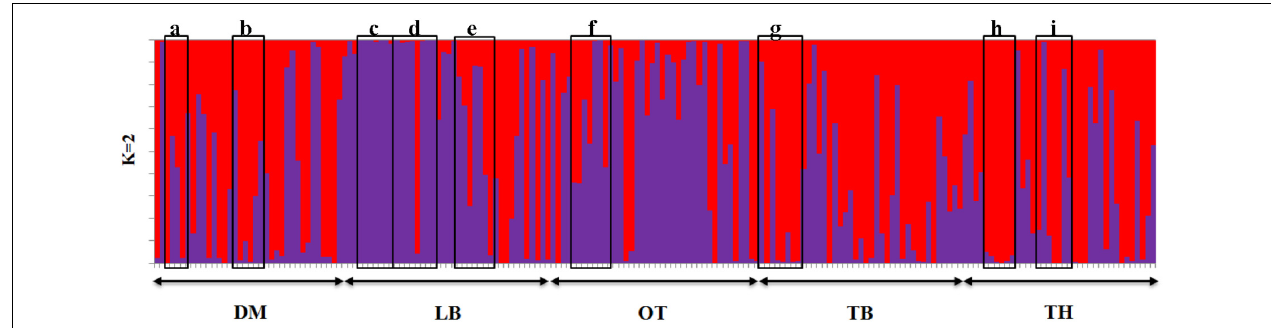
FIGURE 10 | Households having more than five birds in the sampled population (from a–i). Phenotypes in (c) nacked neck and village chicken; (d) village chicken, frizzle feathered, commercial layer; (h) village chicken, naked neck, long legged, cross